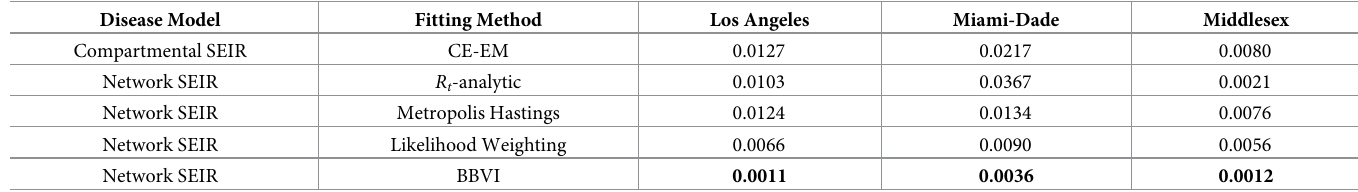
Table 2. Mean daily absolute error (MDAE, Eq 27) for various disease models and fitting procedures across several counties. BBVI fits the NSEIR model to real infec- tion statistics better than Metropolis-Hastings or Likelihood-weighted importance sampling. NSEIR also outperforms Compartmental SEIR model with CE-EM. Disease